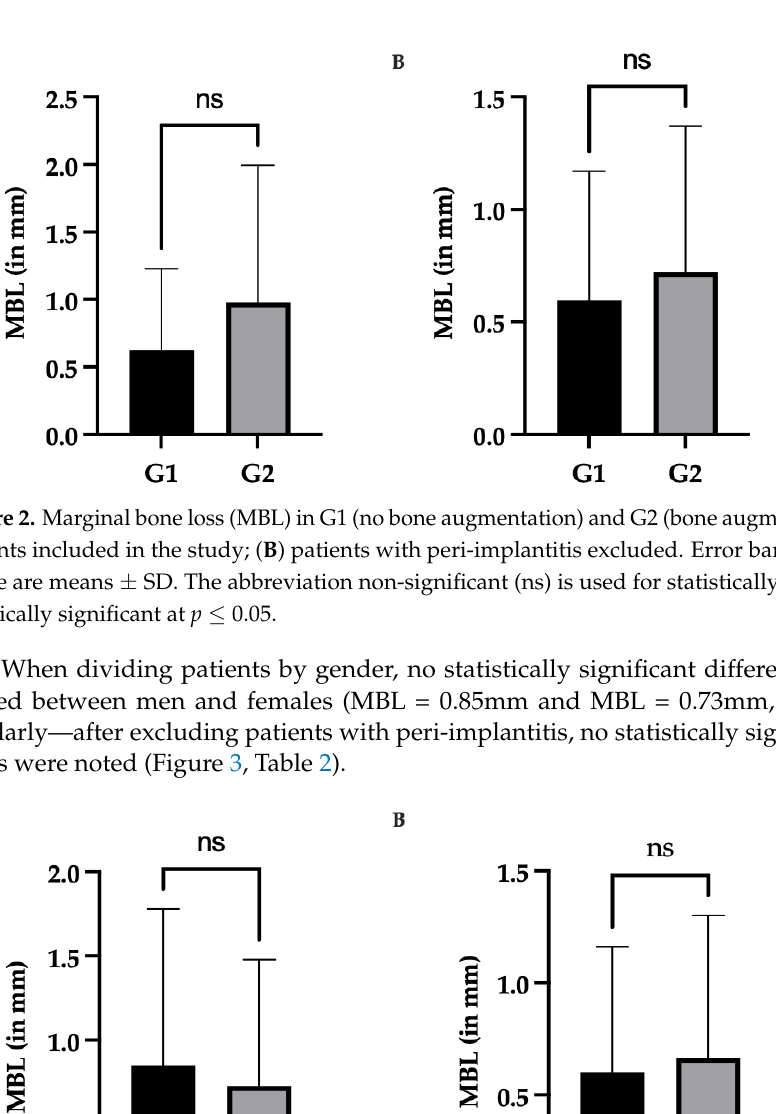
Figure 3. Marginal bone loss (MBL) for both gender groups. ( A ) all patients included in the study; ( B ) patients with peri-implantitis excluded. Error bars shown in this figure are means ± SD. The abbreviation ns is used for statistically nonsignificant, statistically significant at p ≤ 0.05. Table 2. Marginal bone loss (MBL) for both gender groups. Data are means ±